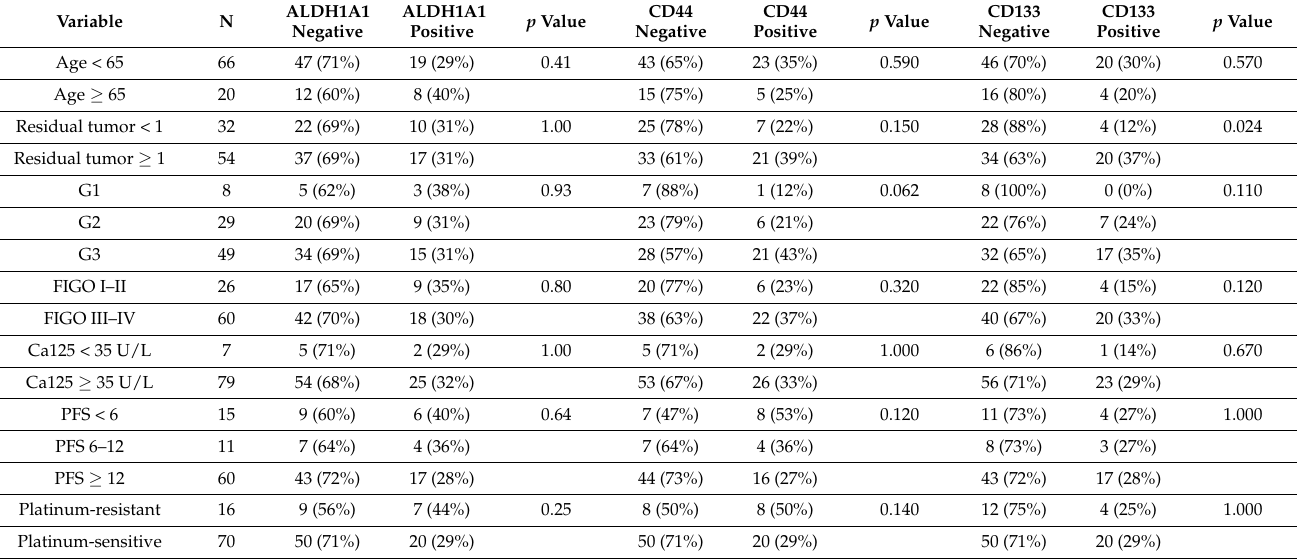
Table 2. Analysis of the relationship between ALDH1A1, CD44, and CD133 expression and clinico- pathological